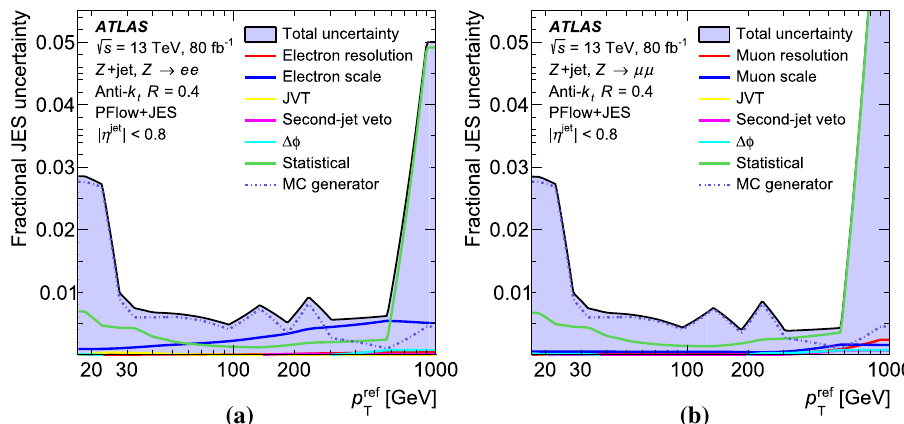
Fig. 13 Systematic uncertainties for PFlow jets as a function of refer- ence p T for a Z → ee + jet events and b Z → μμ + jet events calcu- lated using the MPF technique. Uncertainties due to the JVT, second- jet veto, and (cid:7)φ cuts derive from the analysis technique. Electron or muon (as appropriate) scale and resolution uncertainties are propagated through the analysis from the uncertainties associated with the indi-